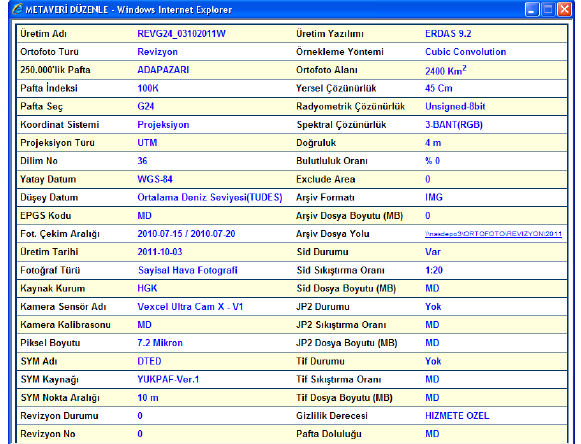
Figure 6. Metadata edit interface